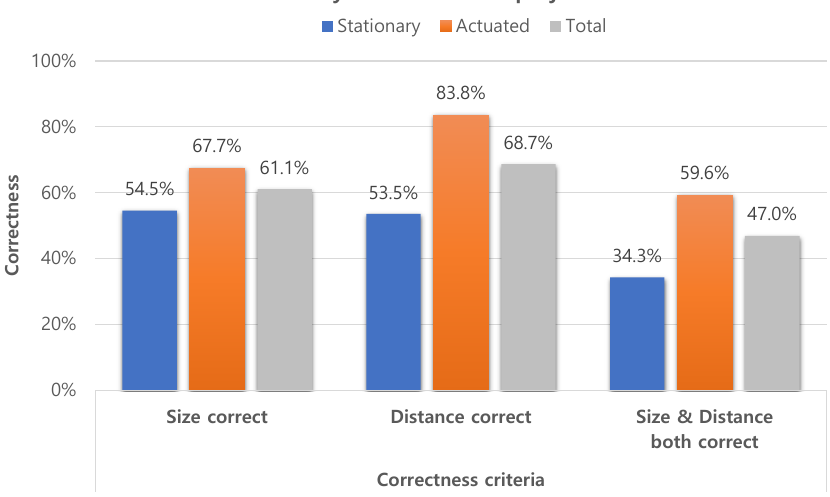
Figure 8. The ratios of correct ratings, determined by three different criteria: size, distance, and both size and